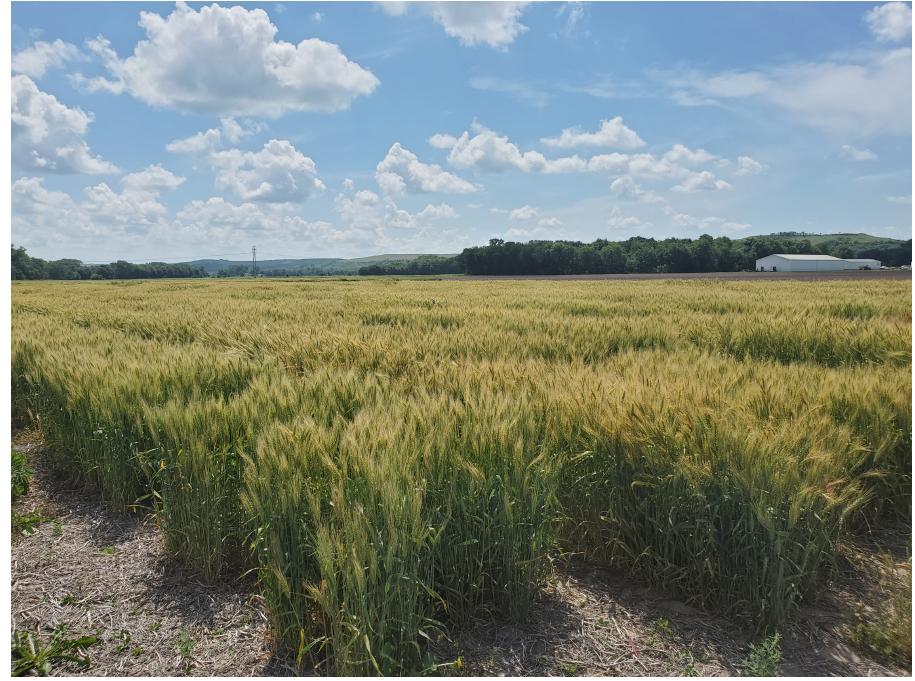
Figure 2. Research site (KSU Agronomy farm) in Manhattan,